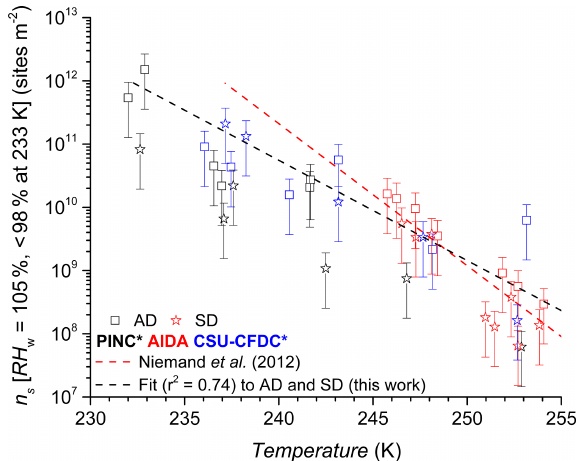
Figure 11. INAS densities as a function of temperature for AD and SD. Error bars are based on 75% sizing due to spherical assump- tion and surface area determination and 15% from particle counting resulting in a relative error of 77% in n s . The asterisk ( ∗ ) denotes that the PINC and CSU-CFDC data have been adjusted by a factor of 3 (see text Sect. 4 for details). Equation for exponential fit (black dashed line) shown in Sect.